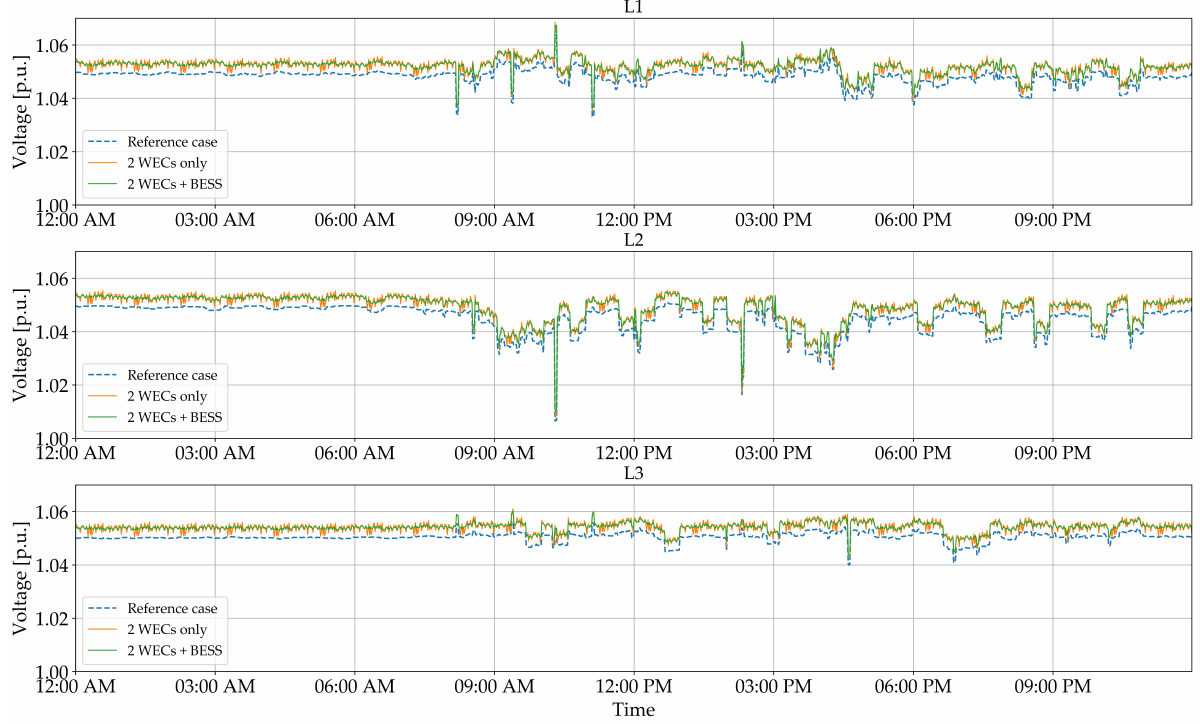
Figure 15. Voltage profiles at the WPF PCC bus for various scenarios in case study